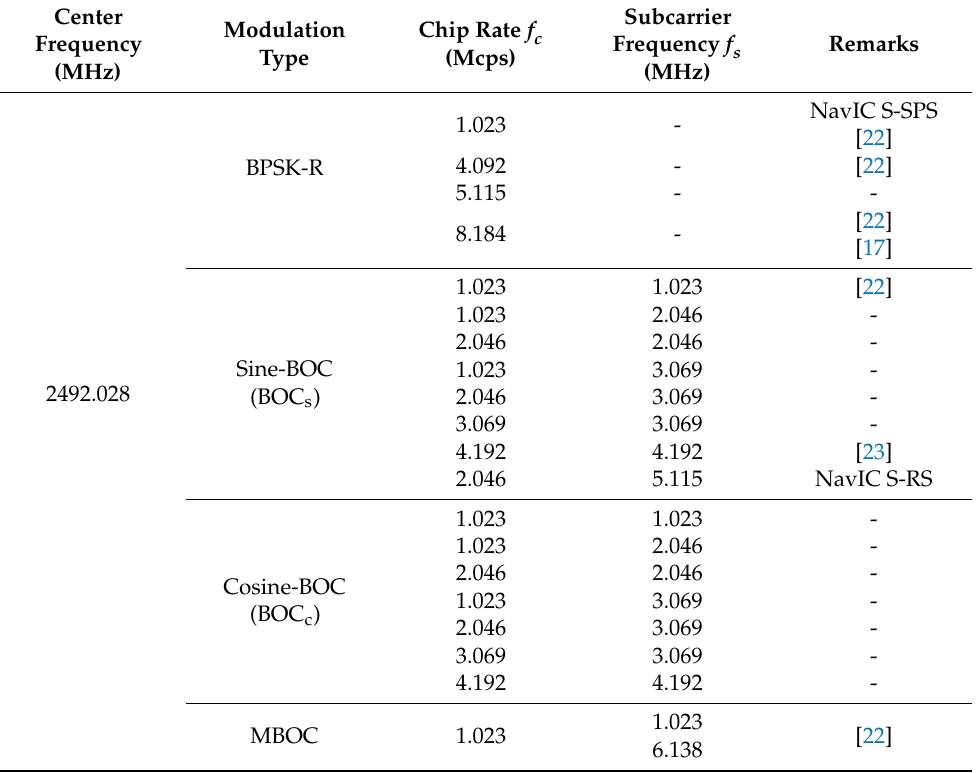
Table 3. Center frequency and modulation methods for each